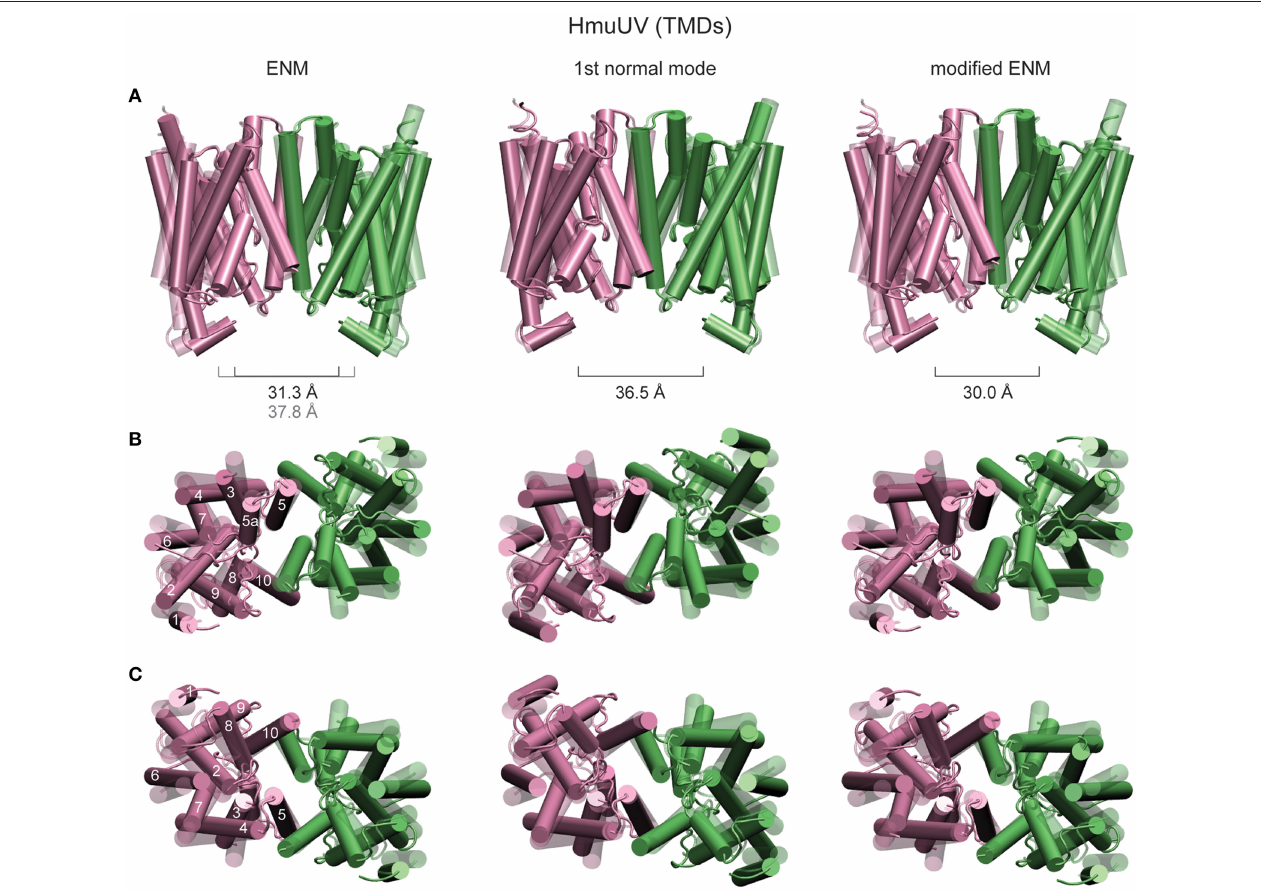
FIGURE 9 | Structural rearrangements of TM helices in HmuUV. The TMDs of the HmuUV apo structure (transparent) are superimposed with those of ligand-bound structures obtained from the simulations and the structural displacements predicted by the normal mode analysis (all solid). TM helices are shown as tubes. The left column shows the same ligand-bound conformation as in Figure 8 , obtained from the usual ENM. Structure changes predicted by the first normal mode are shown in the middle column. Right column: A single ligand-bound conformation as obtained from the modified ENM. Three different perspectives are provided. In row (A) , the front view is chosen and the distance between the coupling helices is given. The view from the periplasm and that from the cytoplasmic side are provided in rows (B,C) , respectively (for clarity the coupling helices have been omitted in these representation). For one TMD the TM helices are assigned their numeric